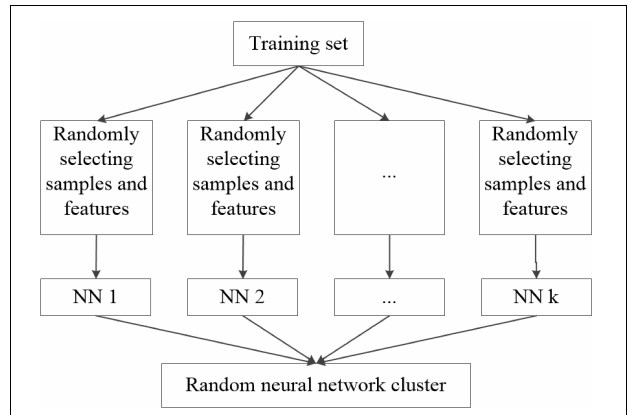
FIGURE 1 | The formation of the random neural network cluster.